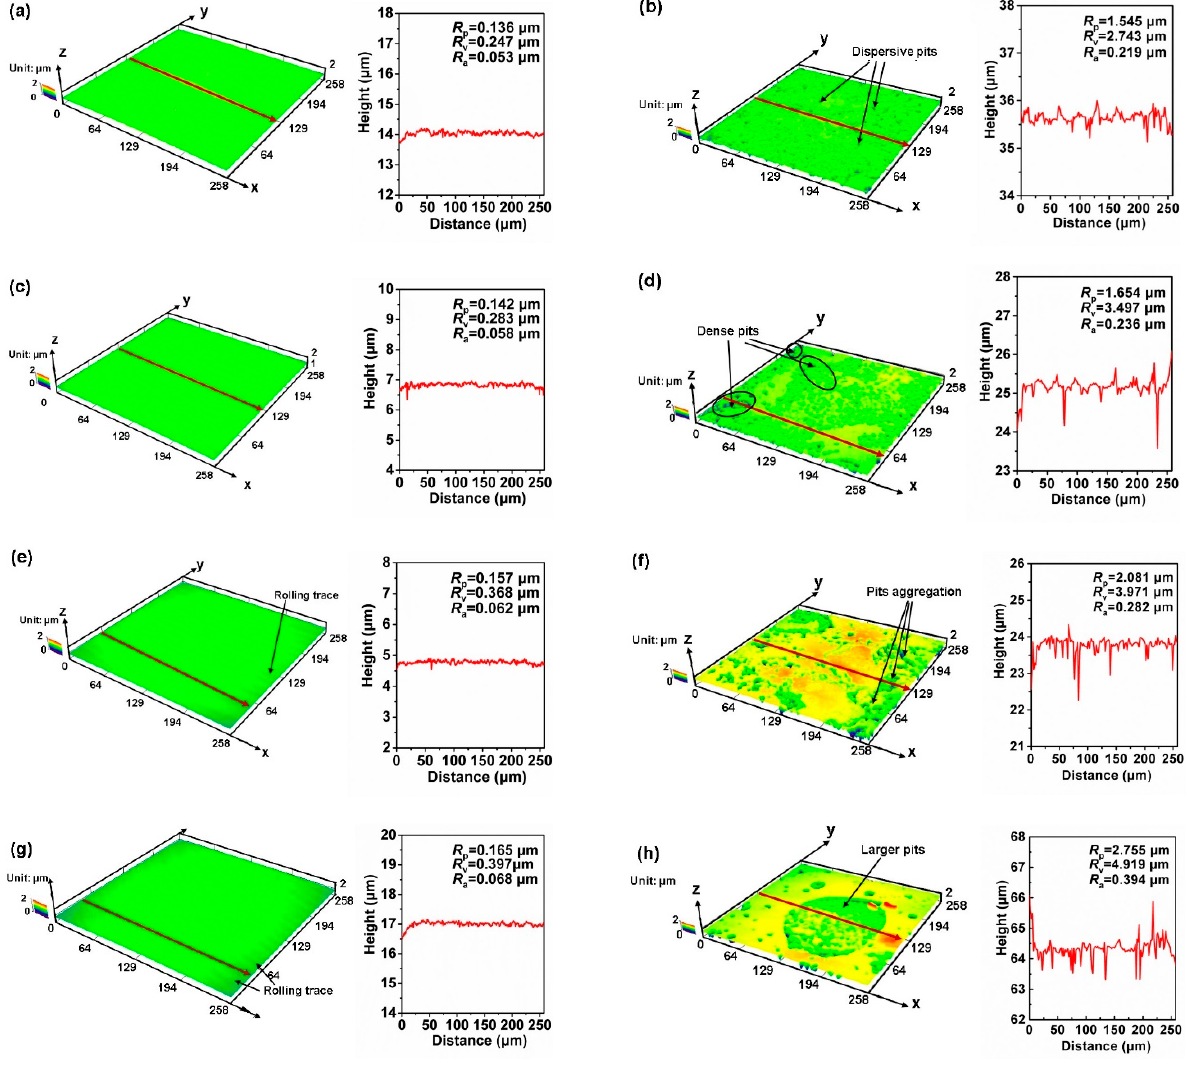
Figure 5. The 3D topographies and height profiles of the Cu electrodes before and after the electrochemical tests under different rolling reductions: ( a , b ) 0%, ( c , d ) 22.7%, ( e , f ) 58.6%, and ( g , h ) 77.3%.